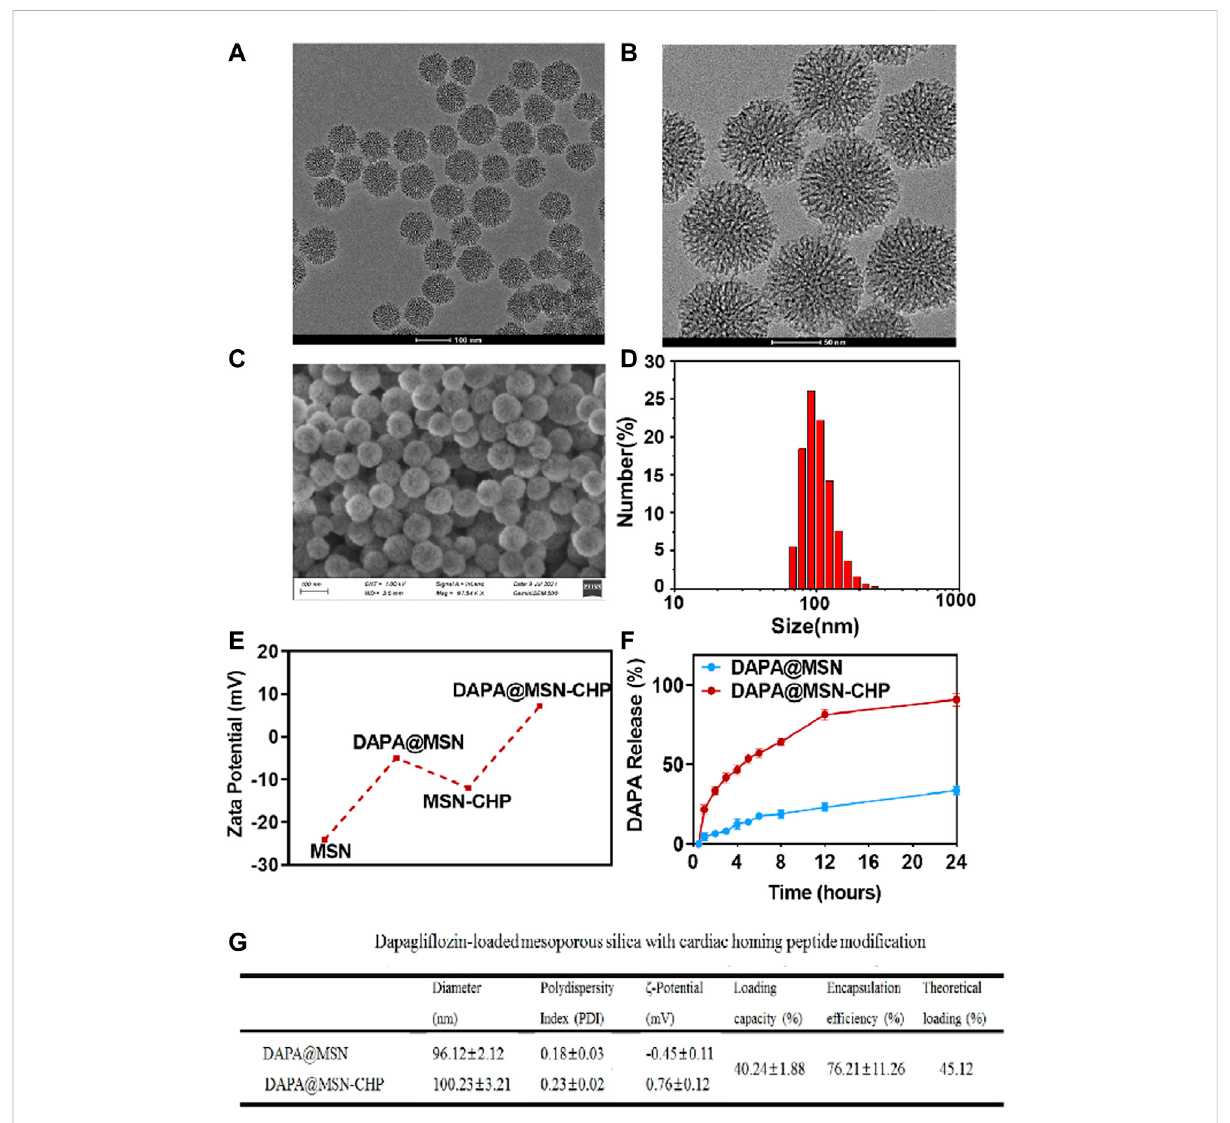
FIGURE 2 TEM image (A) , magni fi cation TEM image (B) and SEM image of the bi-phase prepared MSN (C) . DLS result of size distribution of MSN (D) . Zeta- potentialdataofMSN,DAPA@MSN,MSN-CHPandDAPA@MSN-CHP (E) .DAPAreleasecurveofDAPA@MSN-CHPunderdifferentpHvalues (F) .The corresponding physical and chemical parameters of the DDS (G)